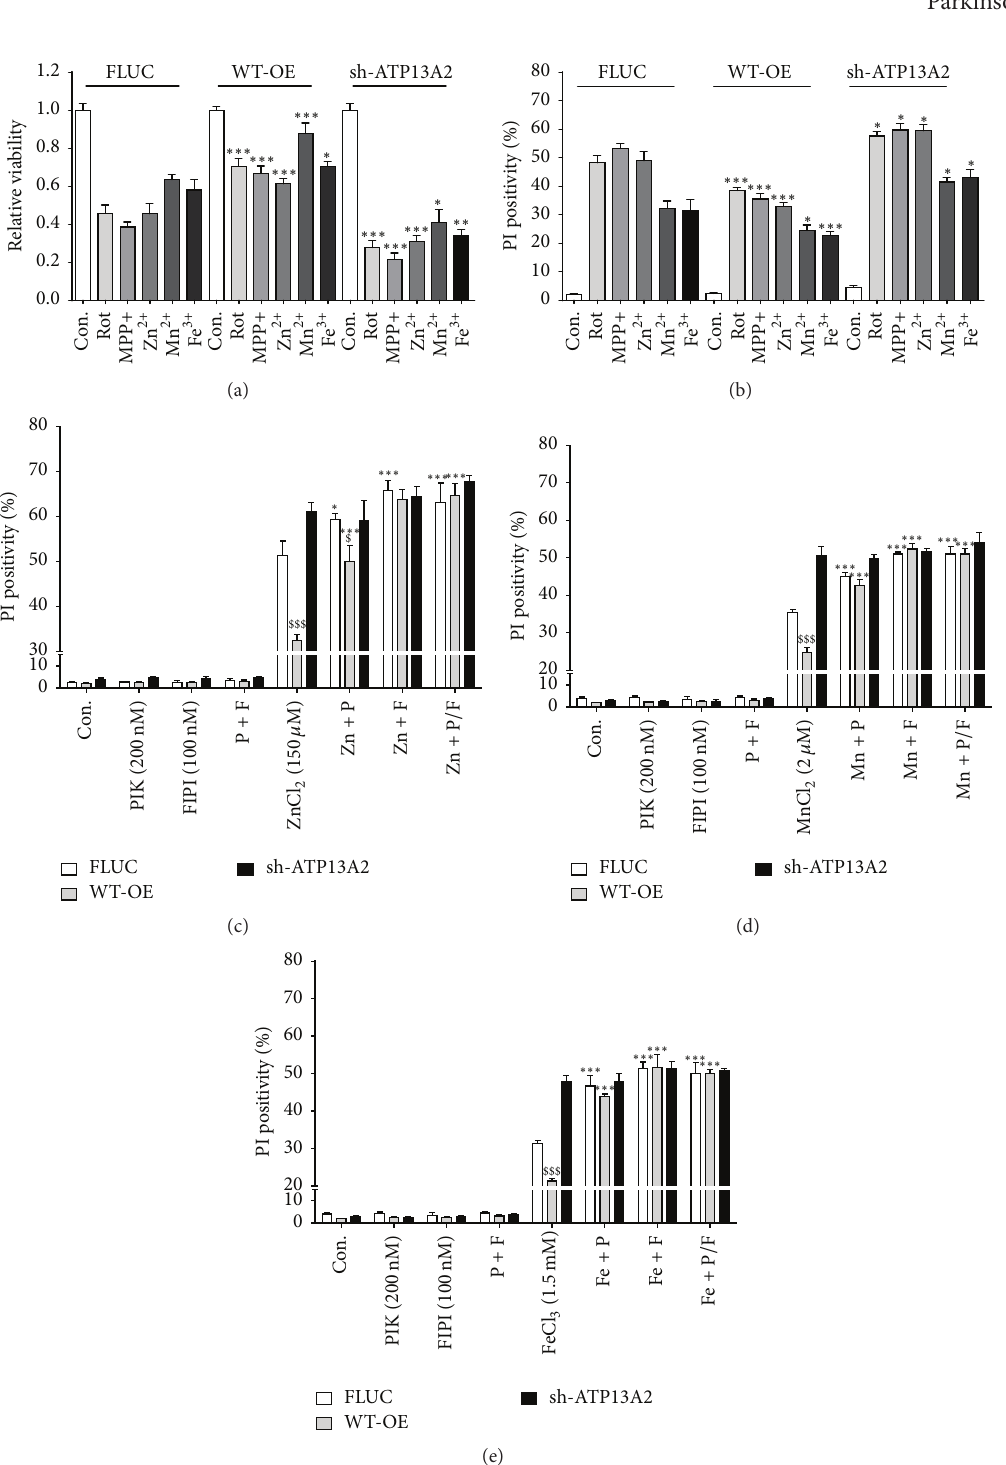
Figure 4: PA and PI(3,5)P2 provide ATP13A2-mediated protection to PD-related metal toxicity. ((a)-(b)) The SHSY5Y cell models stably overexpressing FLUC, WT-OE, or sh-ATP13A2 were exposed for 24 h to rotenone (Rot, 1 𝜇 M, positive control) and MPP+ (50 𝜇 M), as well as the heavy metals Zn 2+ (150 𝜇 M), Mn 2+ (2 𝜇 M), and Fe 3+ (1.5mM). Cell viability was evaluated by the MUH assay (a), whereas cell death was assessed by propidium iodide (PI) stained flow cytometry (b). To test whether the protective role of ATP13A2 depends on the signaling lipids PI(3,5)P2 and PA, the SHSY5Y cell lines were pretreated for 1h with the PIKfyve inhibitor (200nM; P or PIK) and/or the phospholipase D inhibitor (100nM; F or FIPI) prior to the addition of the heavy metals Zn 2+ (c), Mn 2+ (d), and Fe 3+ (e). The level of cellular protection was evaluated by PI stained flow cytometry. Data are the mean of 3 independent experiments ± SD. $ statistical differences between FLUC and WT-OE, ∗ statistical differences within cell line following treatment with inhibitor (1 mark, 𝑃 < 0.05 ; 2 marks, 𝑃 < 0.01 ; 3 marks, 𝑃 < 0.001 ) (ANOVA with Bonferroni post hoc